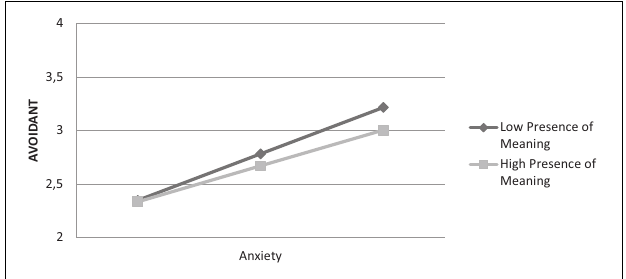
FIGURE 3 | Effect of anxiety on avoidant coping style is moderated by presence of meaning in life.